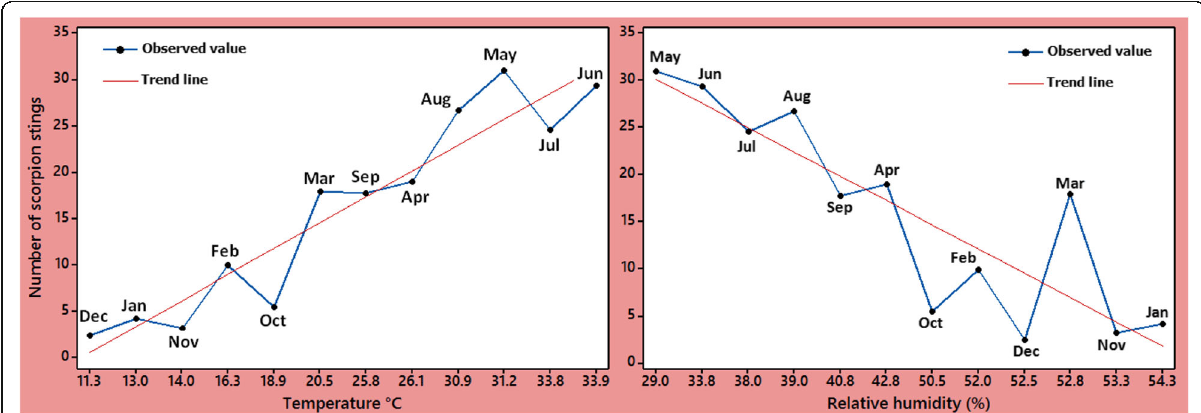
Fig. 3 Distribution of average of scorpion sting cases with respect to average temperature (°C) and relative humidity (%) in different months of the years 2012 to